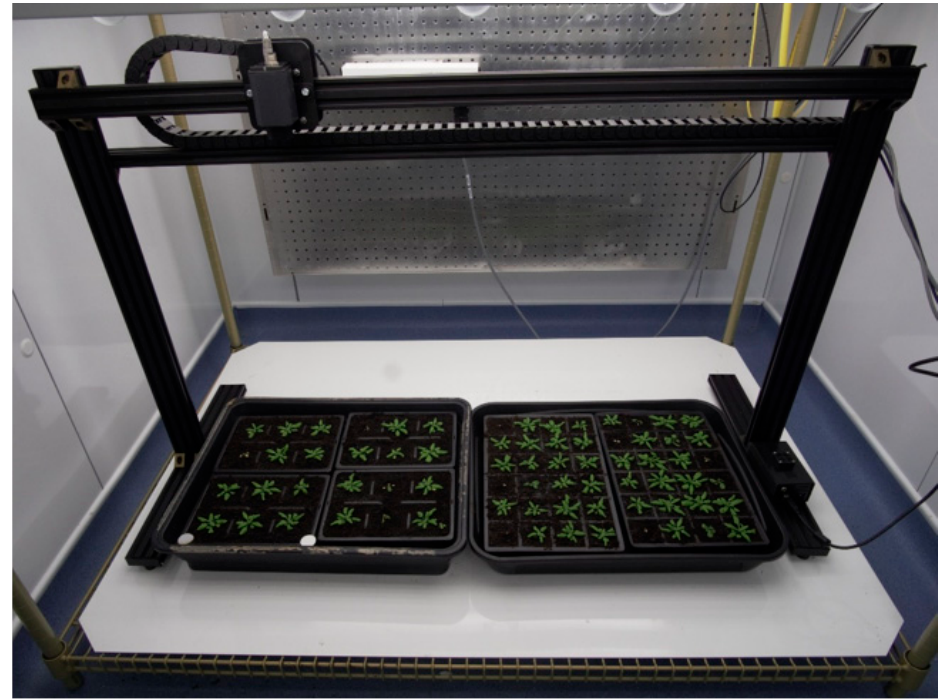
Figure 2. Thermal Imager. For scale, the drive rail is 1.2 m in length.